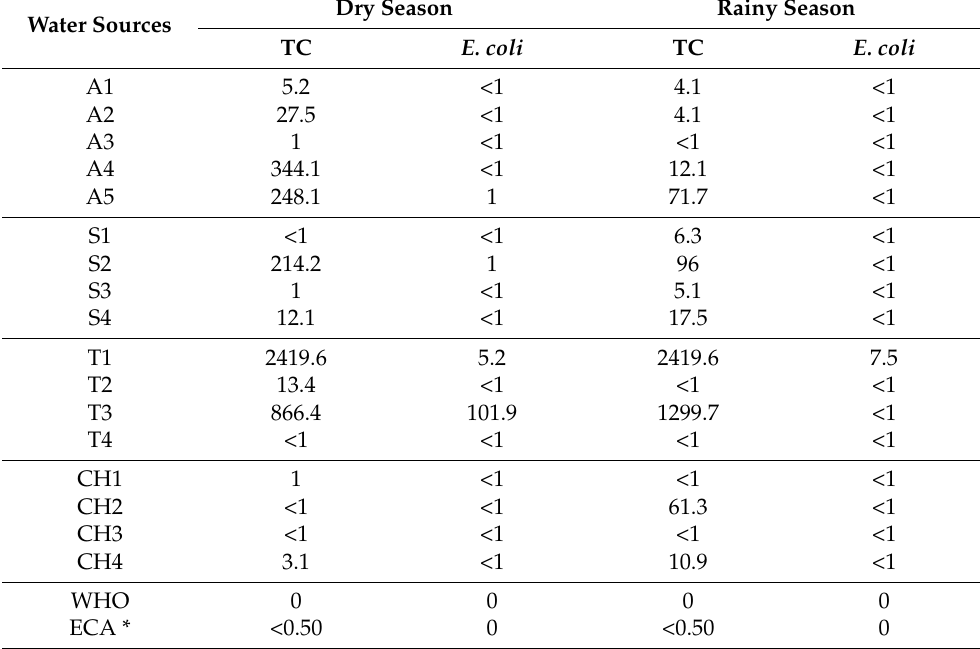
Table 6. Total coliforms (TC) and E. coli in water sources (MPN/100 mL). Water